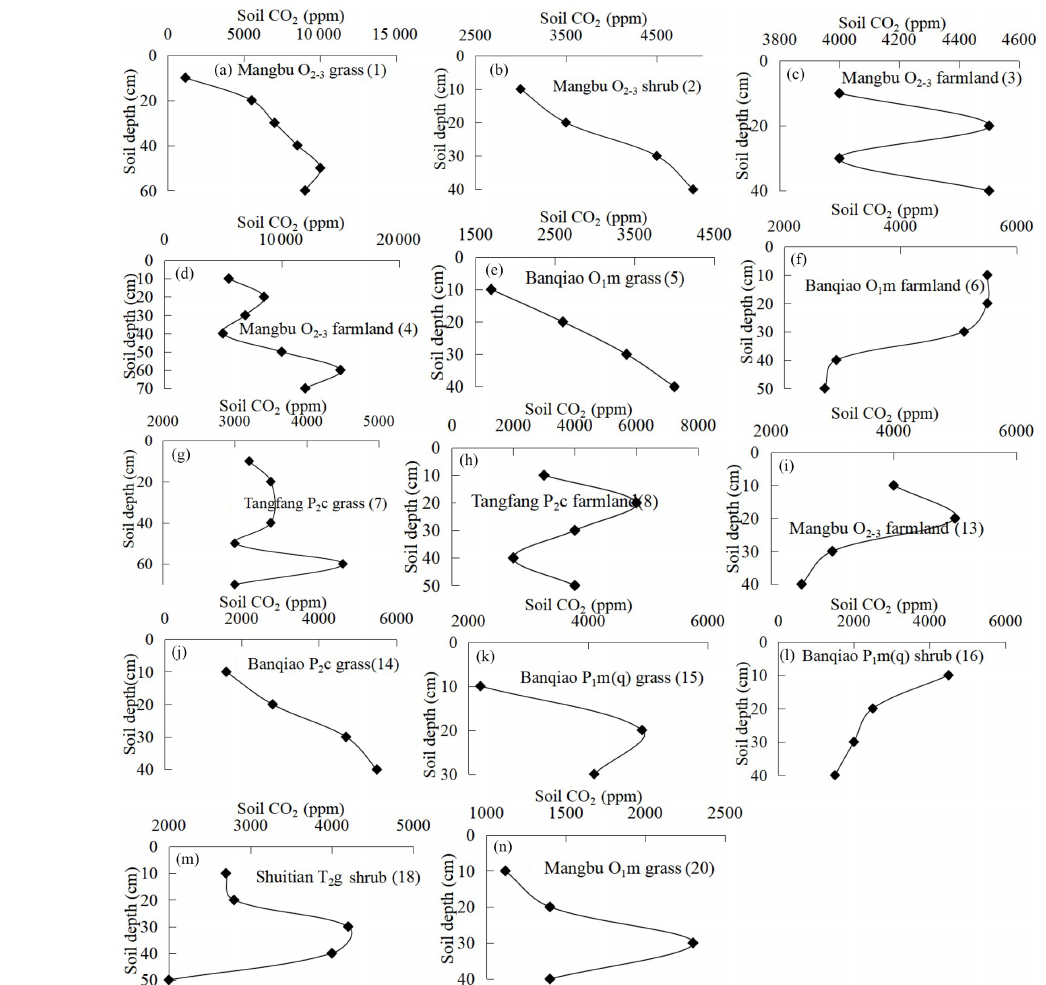
Figure 3. Varying characteristics of soil profile CO 2 concentration in carbonate areas (profile no. in